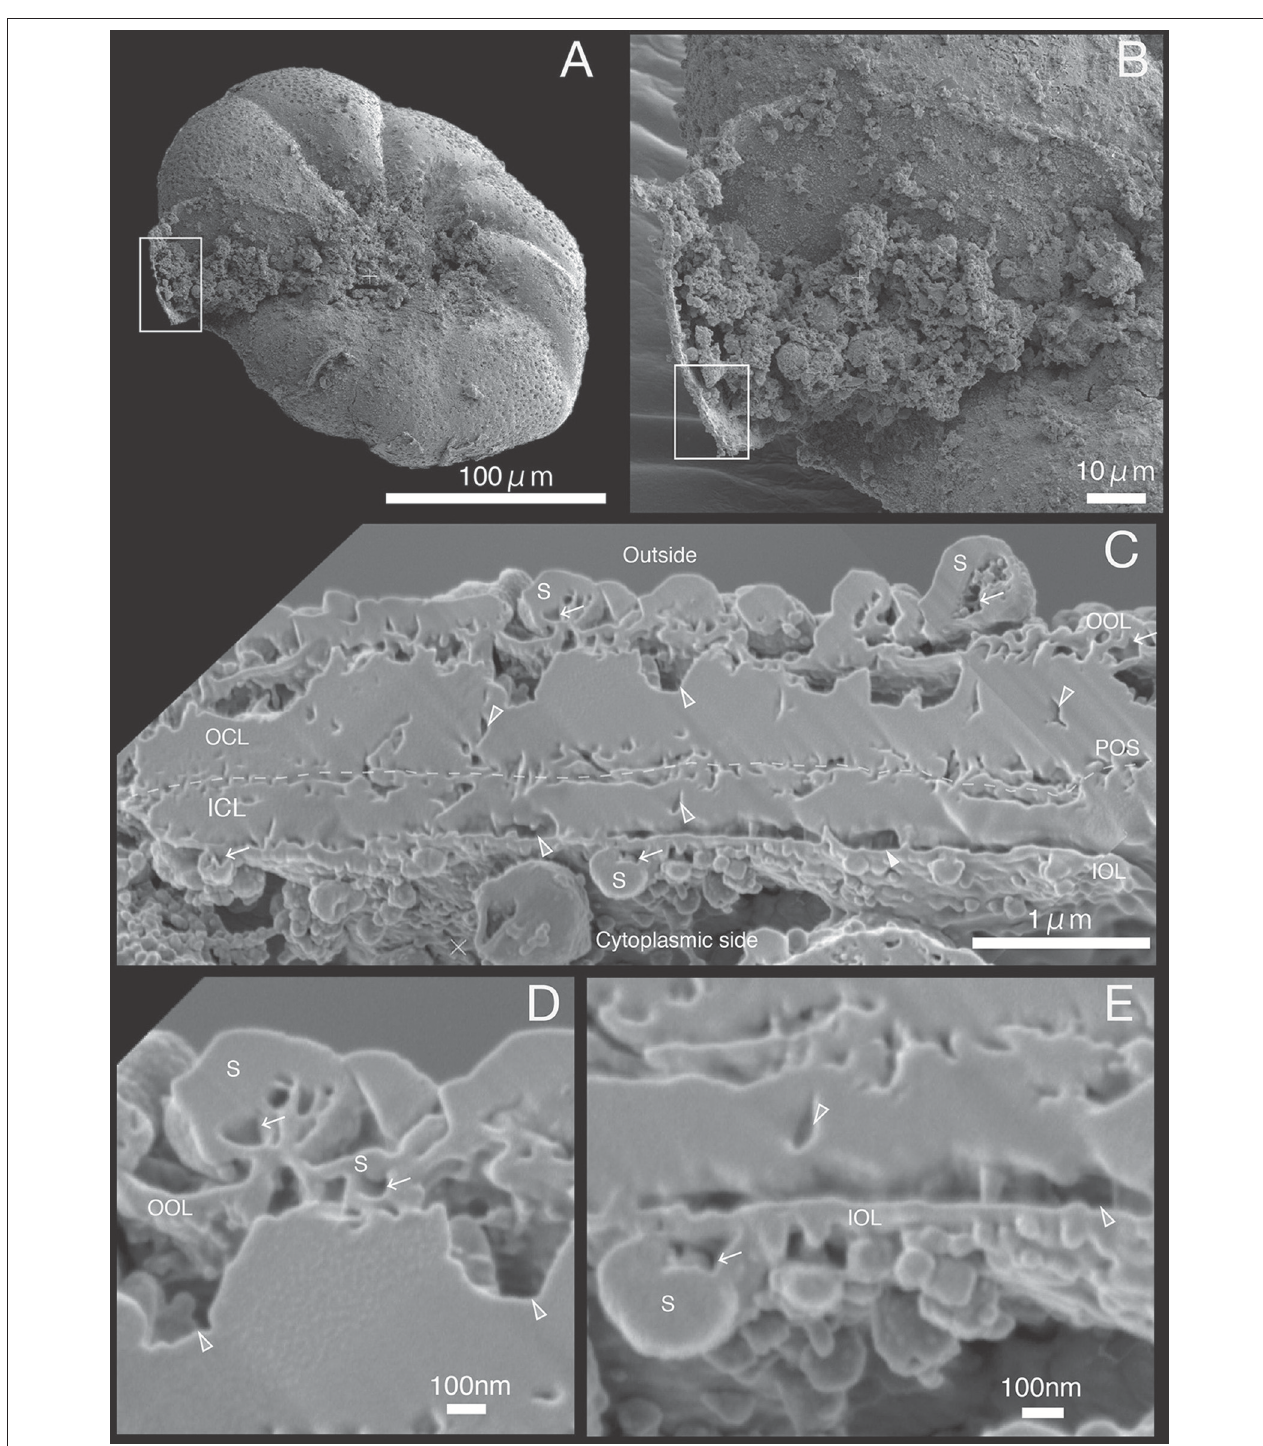
FIGURE 6 | SEM images of specimen #5. (A) Overview. (B) The newly calcified chamber (white rectangle in (A) . The field of FIB processing is indicated by the white rectangle. (C) Composite SEM image of the FIB processed SOC. The upper side is the outer side and whereas the lower side is the cytoplasmic side. White dotted line in the calcareous layer indicates the boundary between outer side and cytoplasmic side of calcareous layer. (D) Magnified image of the contact place between outer organic layer and outer calcareous layer. (E) Higher magnification showing the adjoining place between inner organic layers with inner calcareous layer. OOL, outer organic layer; OCL, outer calcareous layer; POS, primary organic sheet; ICL, inner calcareous layer; IOL, inner organic layer; S, spherical structures; CM, calcareous materials; gray triangles, void; white arrows, cavities in the organic structure.